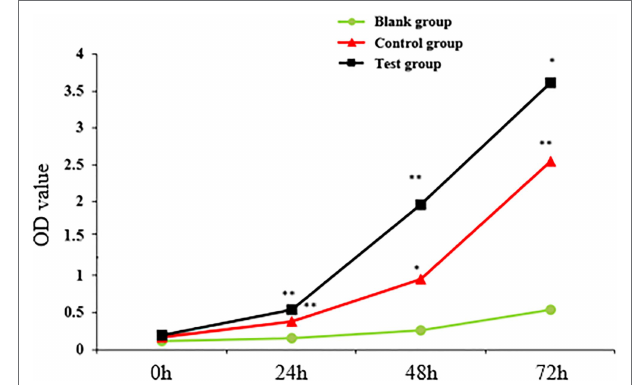
FIGURE 11 | Detection of sheep skin fibroblast proliferation efficiency. * indicates significant difference ( p < 0.05), and ** indicates extremely significant difference ( p <0.01). Unmarked means the difference is not significant ( p >